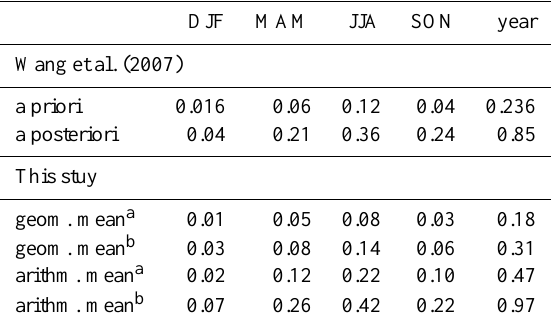
Table 7. Comparison of new SNO x to a top-down study in eastern